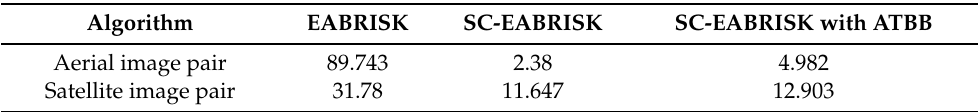
Table 6. Comparisons of the TC (seconds) by using aerial and satellite image pairs with different al-